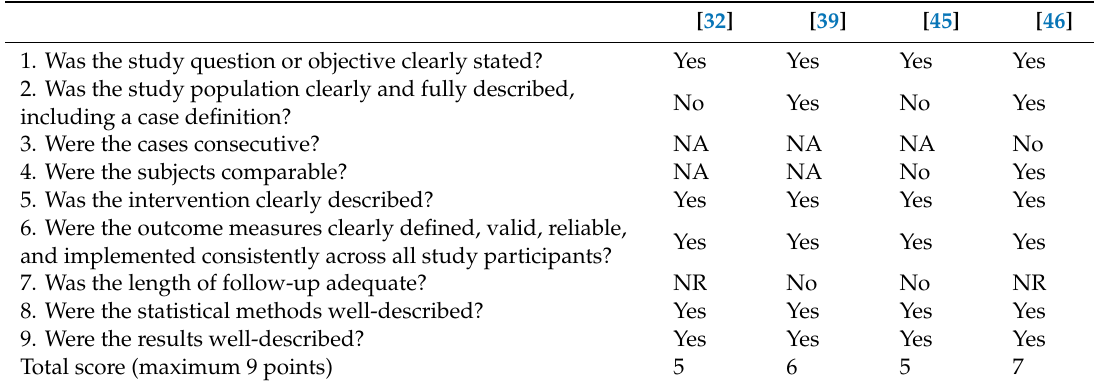
Table 4. Quality assessment of case studies.